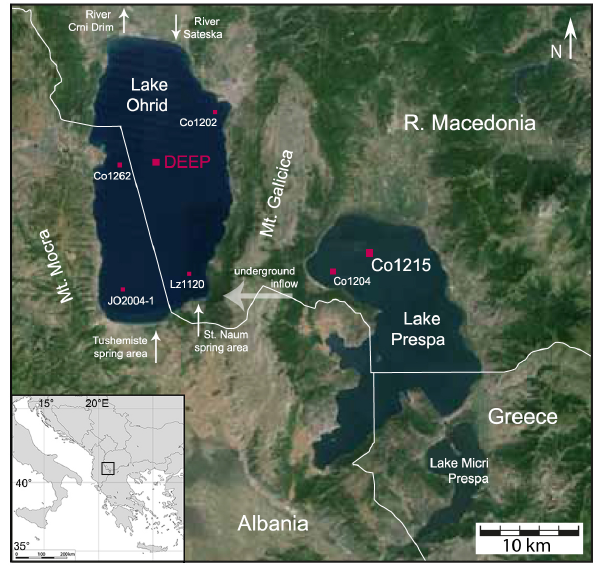
Figure 1. Map of the northern Mediterranean region showing the lo- cation of lakes Ohrid and Prespa. Marked in purple are the locations of the cores: JO2004 (Belmecheri et al., 2009), Lz 1120, Co1202, Co1262 and from field campaigns at Lake Ohrid between 2005 and 2012, cores Co1204 and Co1215 recovered from Lake Prespa dur- ing field campaigns in 2009 and 2011; (Wagner et al., 2009, 2010, 2012) and the DEEP site core 5045-1, retrieved during the SCOP- SCO deep drilling campaign at Lake Ohrid in 2013 (Wagner et al., 2014a). Modified from Francke et al.